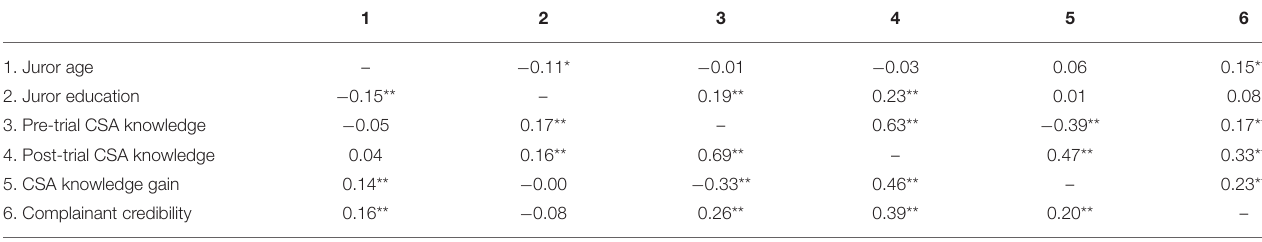
TABLE 2 | Intercorrelations between juror demographic characteristics, CSA knowledge, and perceived complainant credibility.